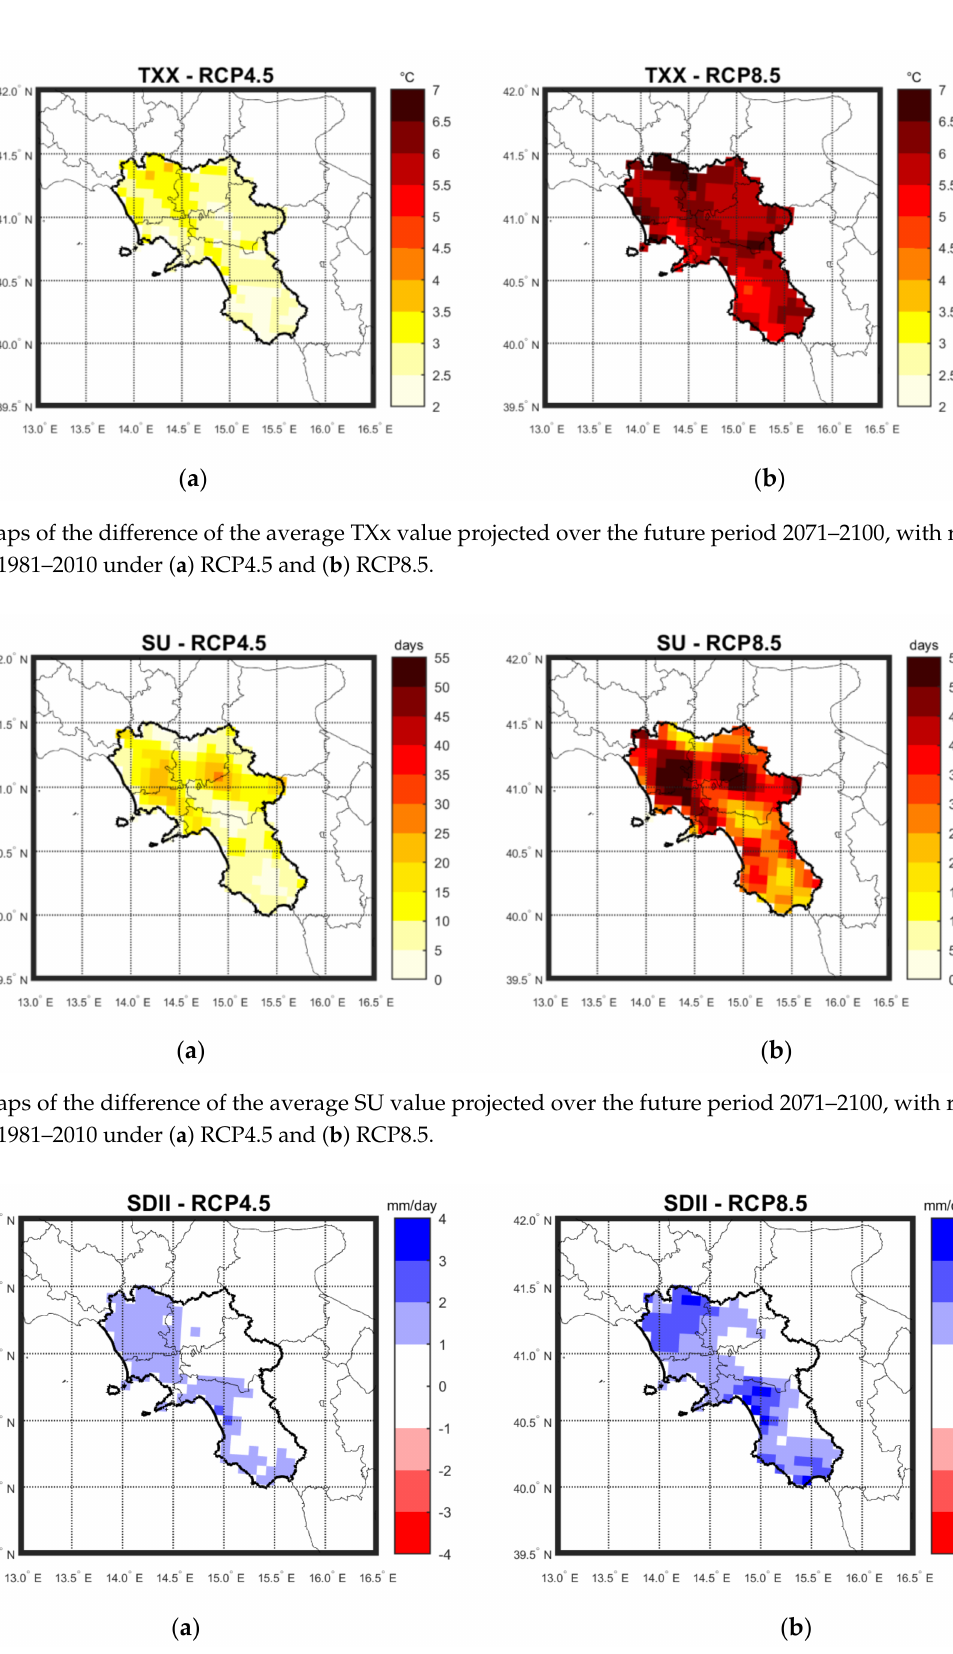
Figure 9. Maps of the difference of the average SDII value projected over the future period 2071–2100, with respect to the past period 1981–2010 under ( a ) RCP4.5 and ( b )